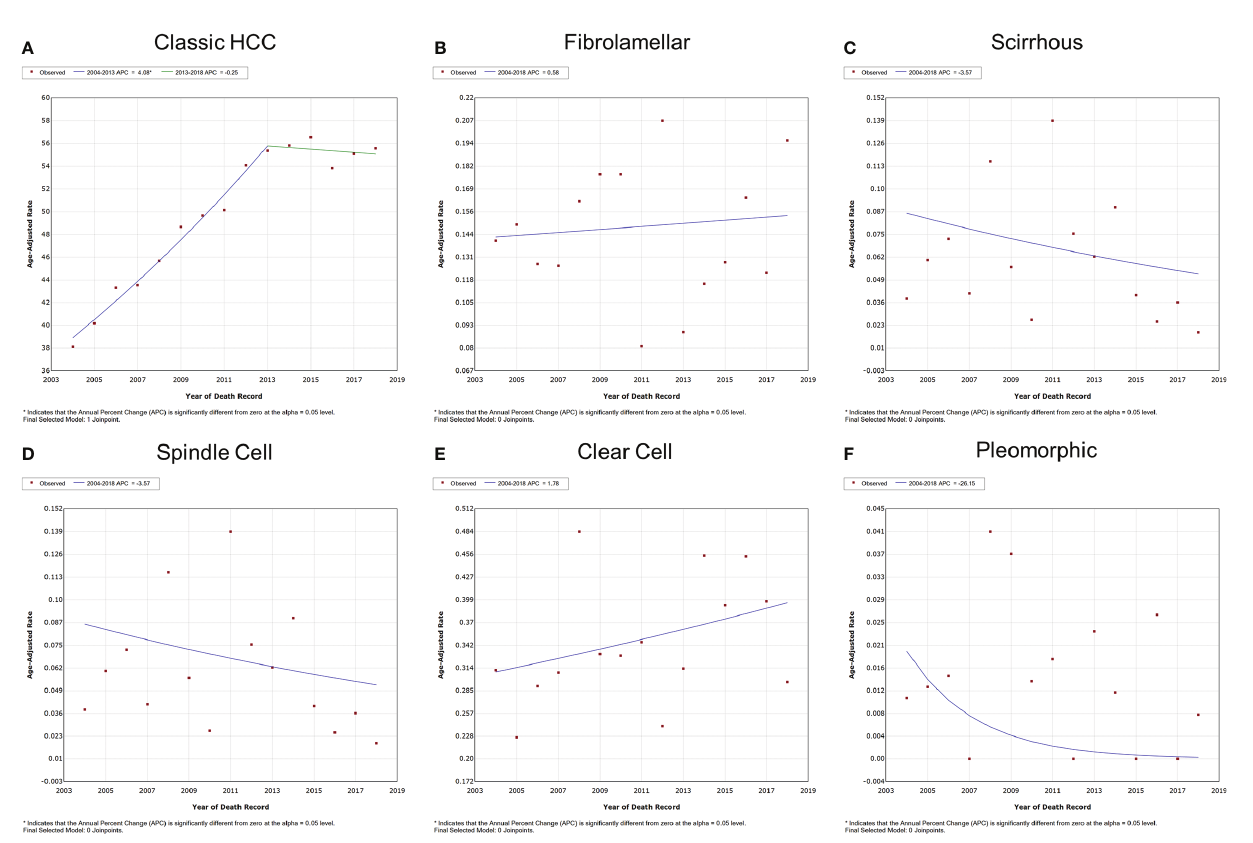
FIGURE 3 | Variation trends for the overall IBM of different pathological subtypes of HCC from 2004 to 2018. (A) Classic HCC, (B) fi brolamellar carcinoma, (C) scirrhous carcinoma, (D) spindle cell carcinoma, (E) clear cell carcinoma, and (F) pleomorphic carcinoma. IBM, incidence-based mortality; HCC, hepatocellular